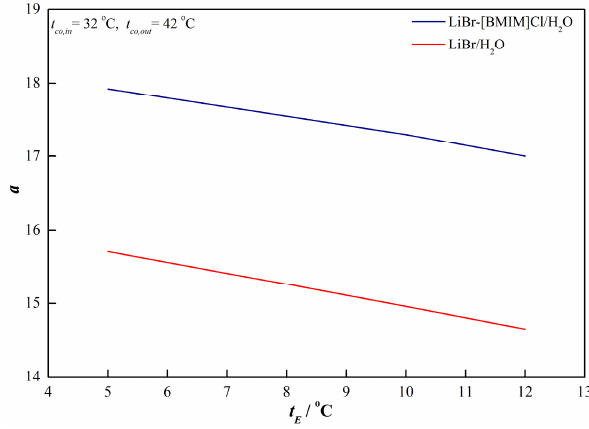
Figure 9. Variations of a with the evaporation temperature t E .